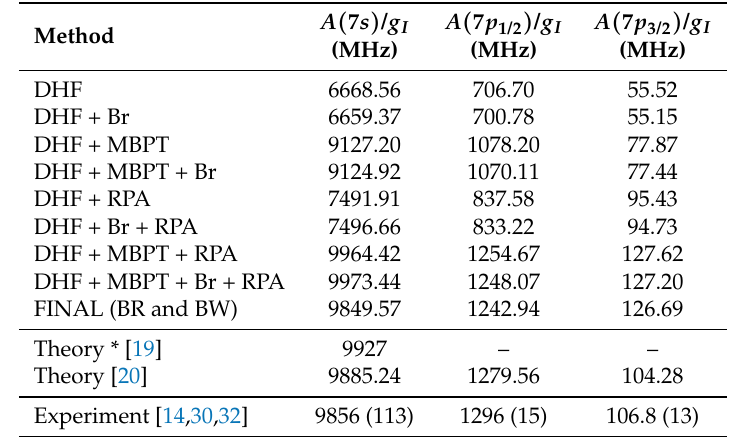
Table 3. Calculated HFS constants for low-lying states of the neutral 210 Fr. We use a point-like magnetic dipole approximation, as described by Equation (5), and assume that R = 7.1766 fm and g I = 0.733. Then, in the final results, we add Bohr–Weisskopf correction for d nuc = 0.49. Available experimental data and other theoretical relativistic coupled-cluster results are also